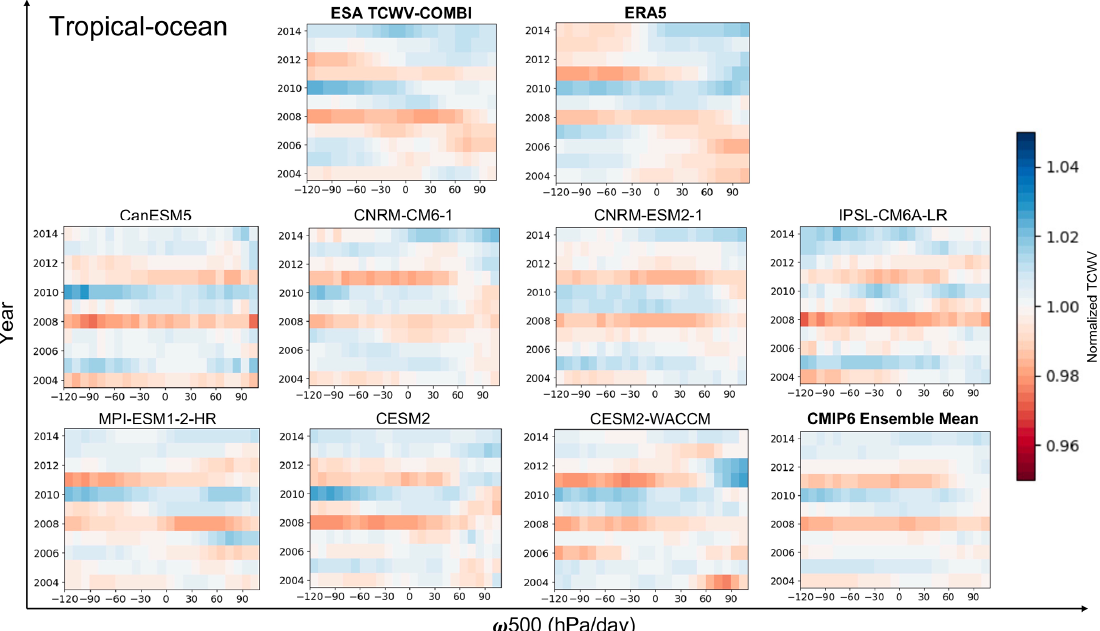
Figure 11. Normalized TCWV with respect to the 2004–2014 mean over tropical-ocean areas at each dynamical interval ( ω 500) in 10hPad − 1 computed from each data